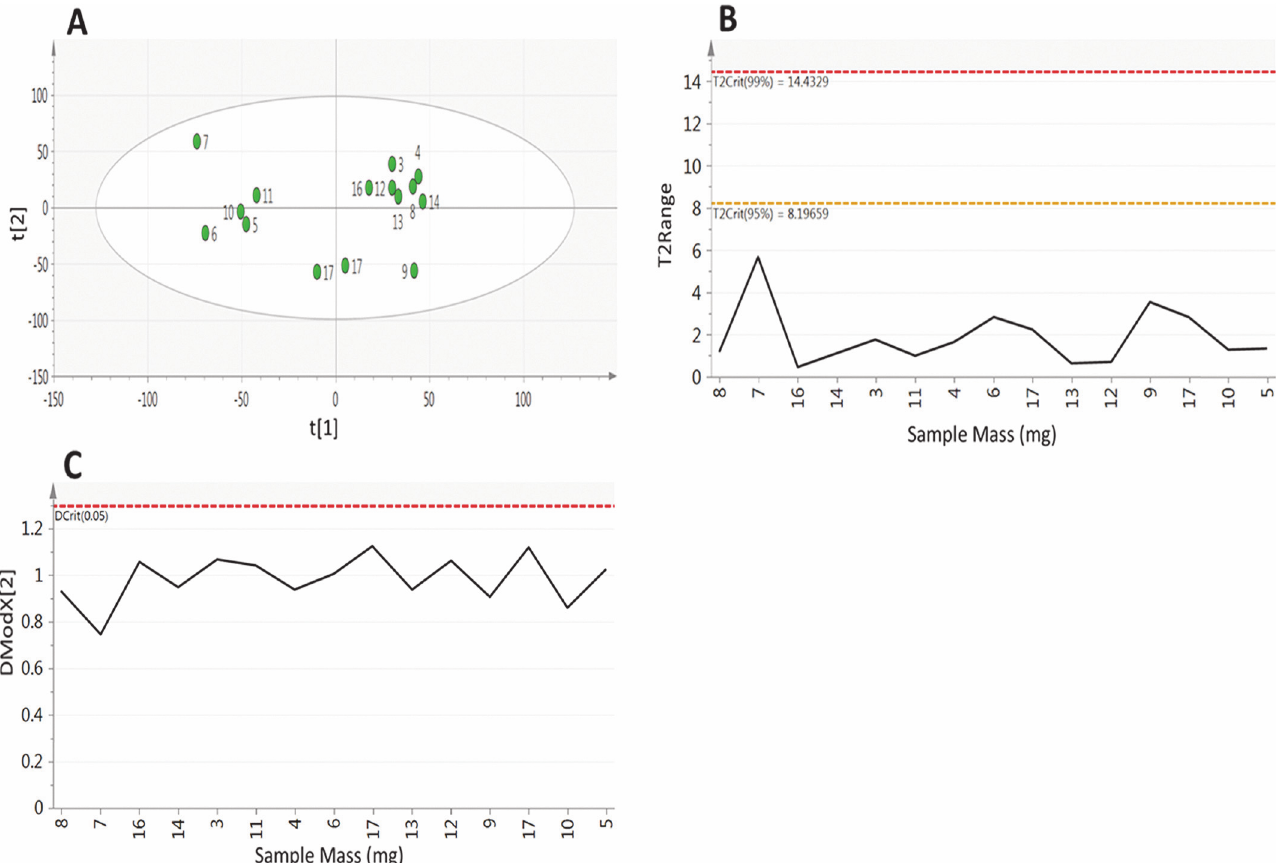
Fig 6. Principal component analysis of samples (components = 2, R 2 X 0.354, Q 2 0.049) performed on metabolite features identified in at least 73% of samples in experiment 2. A) scores plot where point labels represent sample mass B) Hotelling ’ s T 2 and C) DModX plot of analytical samples, showing that sample mass has no effect on overall metabolite